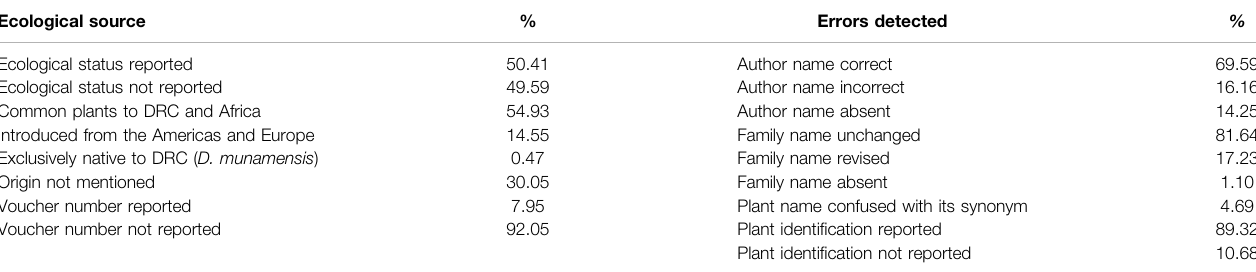
TABLE 2 | Quality analysis of ethnobotany information. Ecological